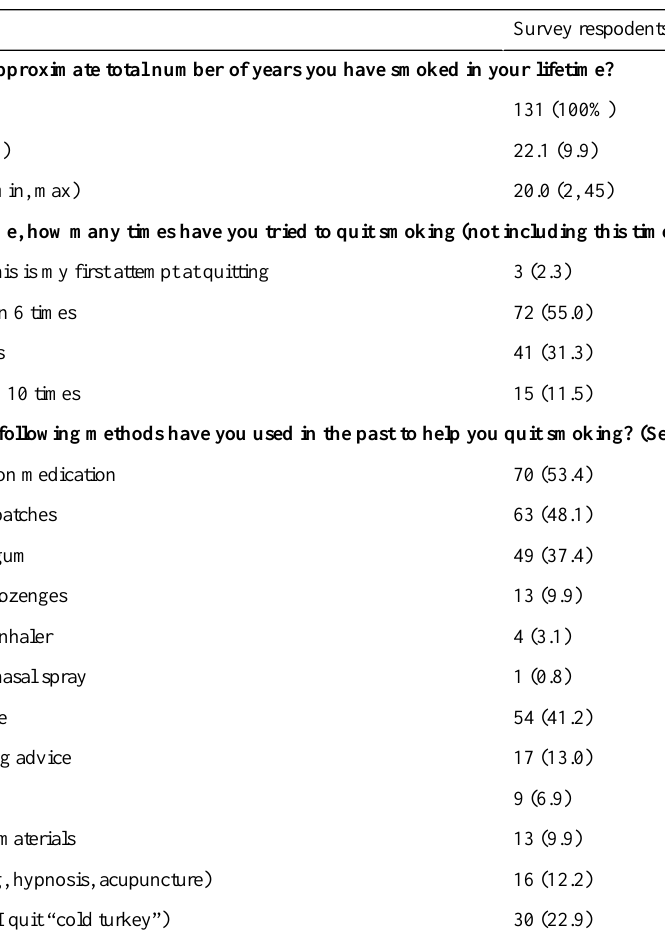
Table 2. Smoking history and smoking status among survey